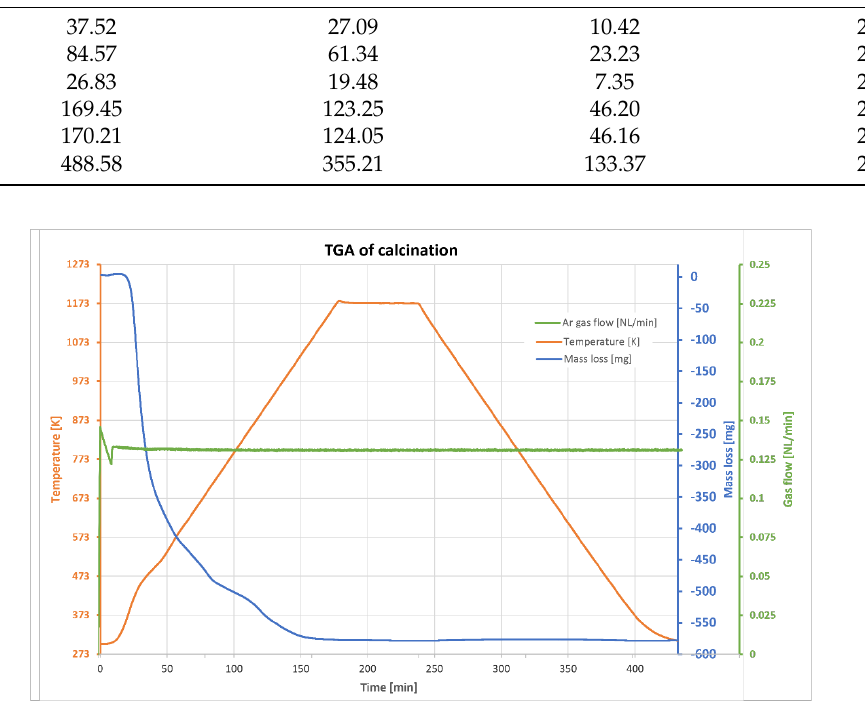
Figure 5. Thermogravimetric analysis from the calcination process of the raw PMMN.